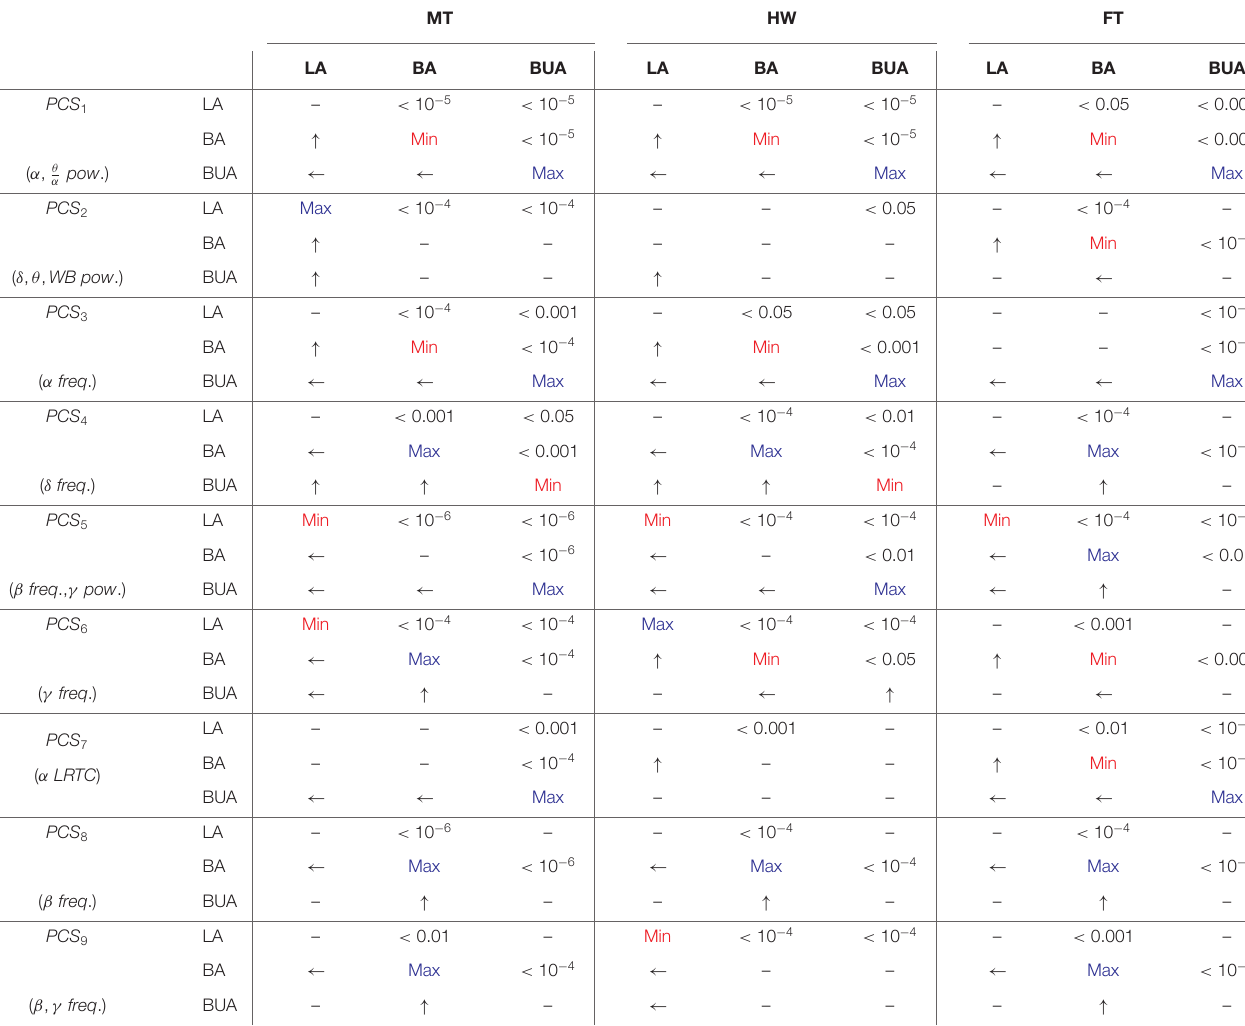
TABLE 1 | Tukey post-hoc multiple comparison testing for within-background